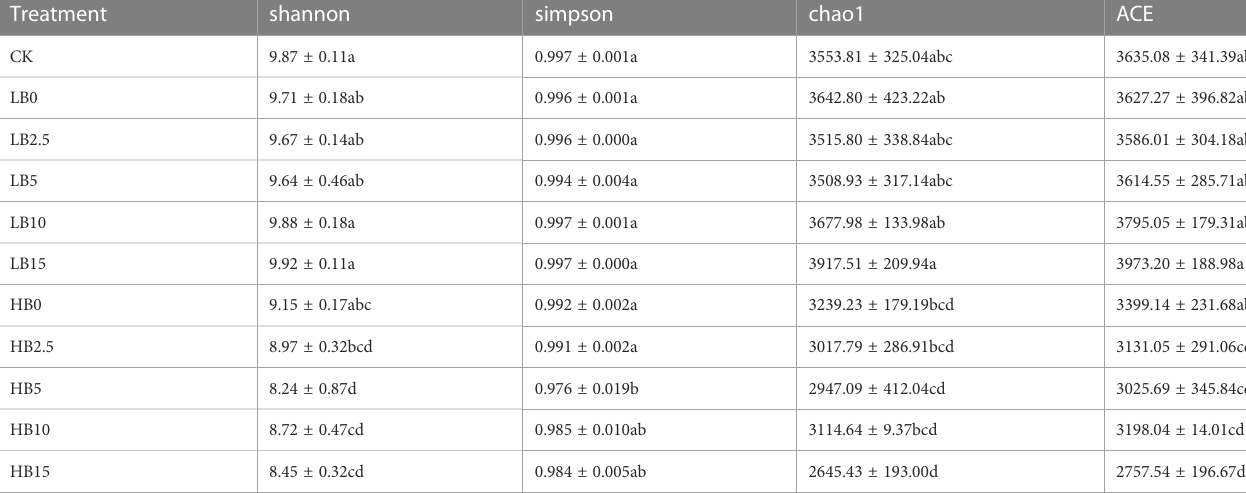
TABLE 1 Analysis of Alpha diversity index of soil bacteria between groups.